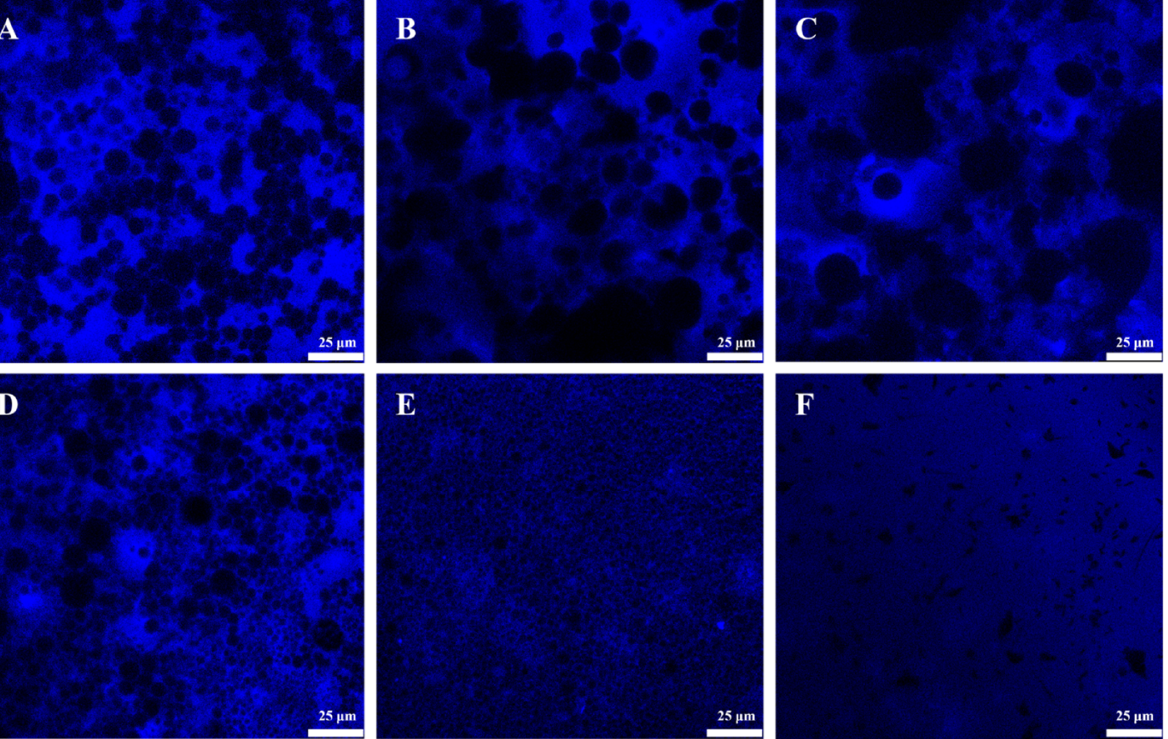
Figure 3. CLSM images of dual-structured gel emulsions containing 50 wt% sunflower oil prepared by 4 wt% GA nanofibrils and different MG concentrations: ( A ) 0, ( B ) 1, ( C ) 2, ( D ) 4, ( E ) 8, and ( F ) 16 wt%. The gel emulsions were prepared using the GA fibrillar network dyed with ThT, which is blue in the images. All scale bars are 25 μ m.